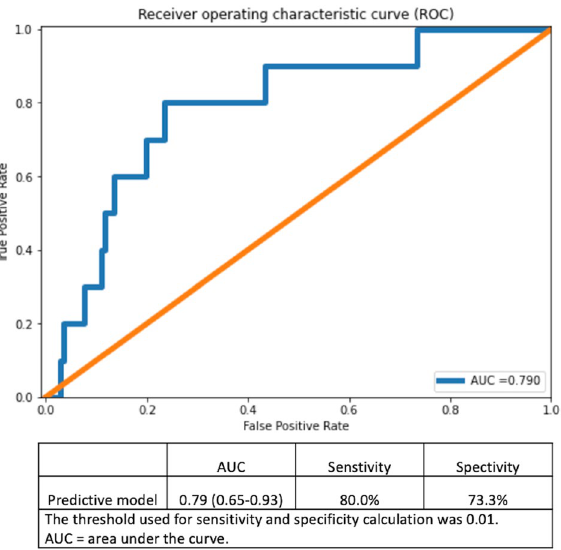
Figure 5. Receiver operating curve of the predictive model. The mean squared error between predicted and known values on the test set was